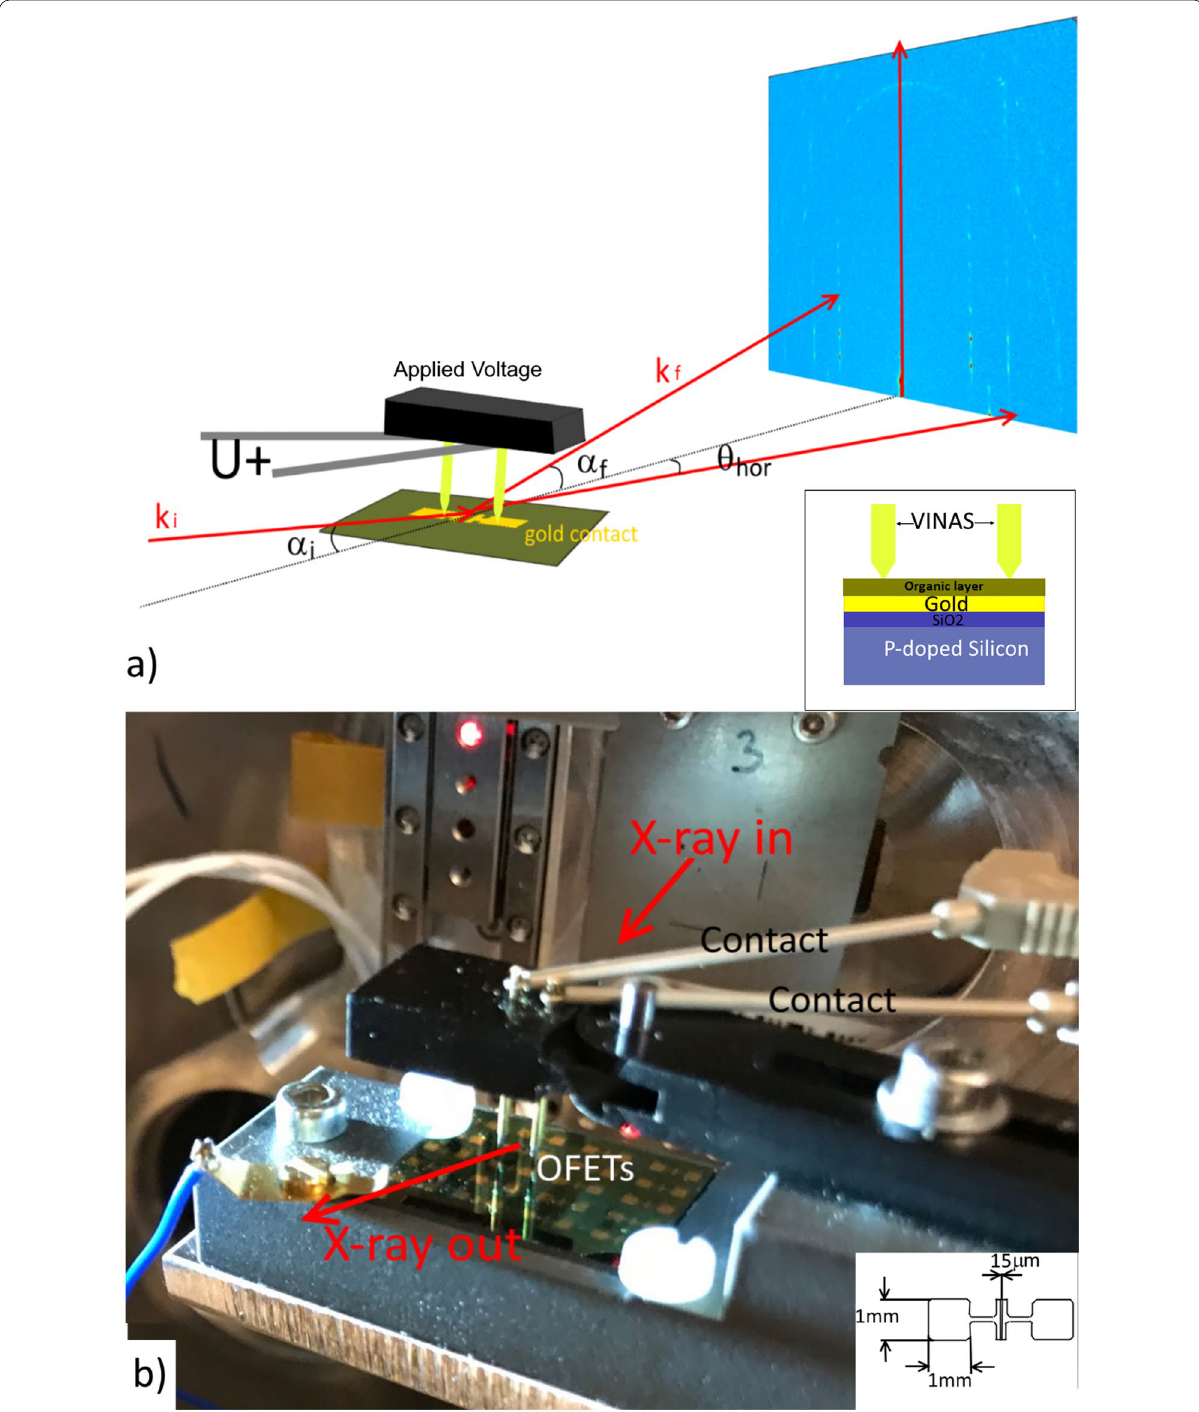
Fig. 1 a Scheme of the VINAS setup with installed sample and marked vertical contacts during in situ measurements; b photograph of VINAS setup installed at P03 nanofocus endstation (PETRA III, DESY), real setup of reported studies, inset: schematic image of the OFET